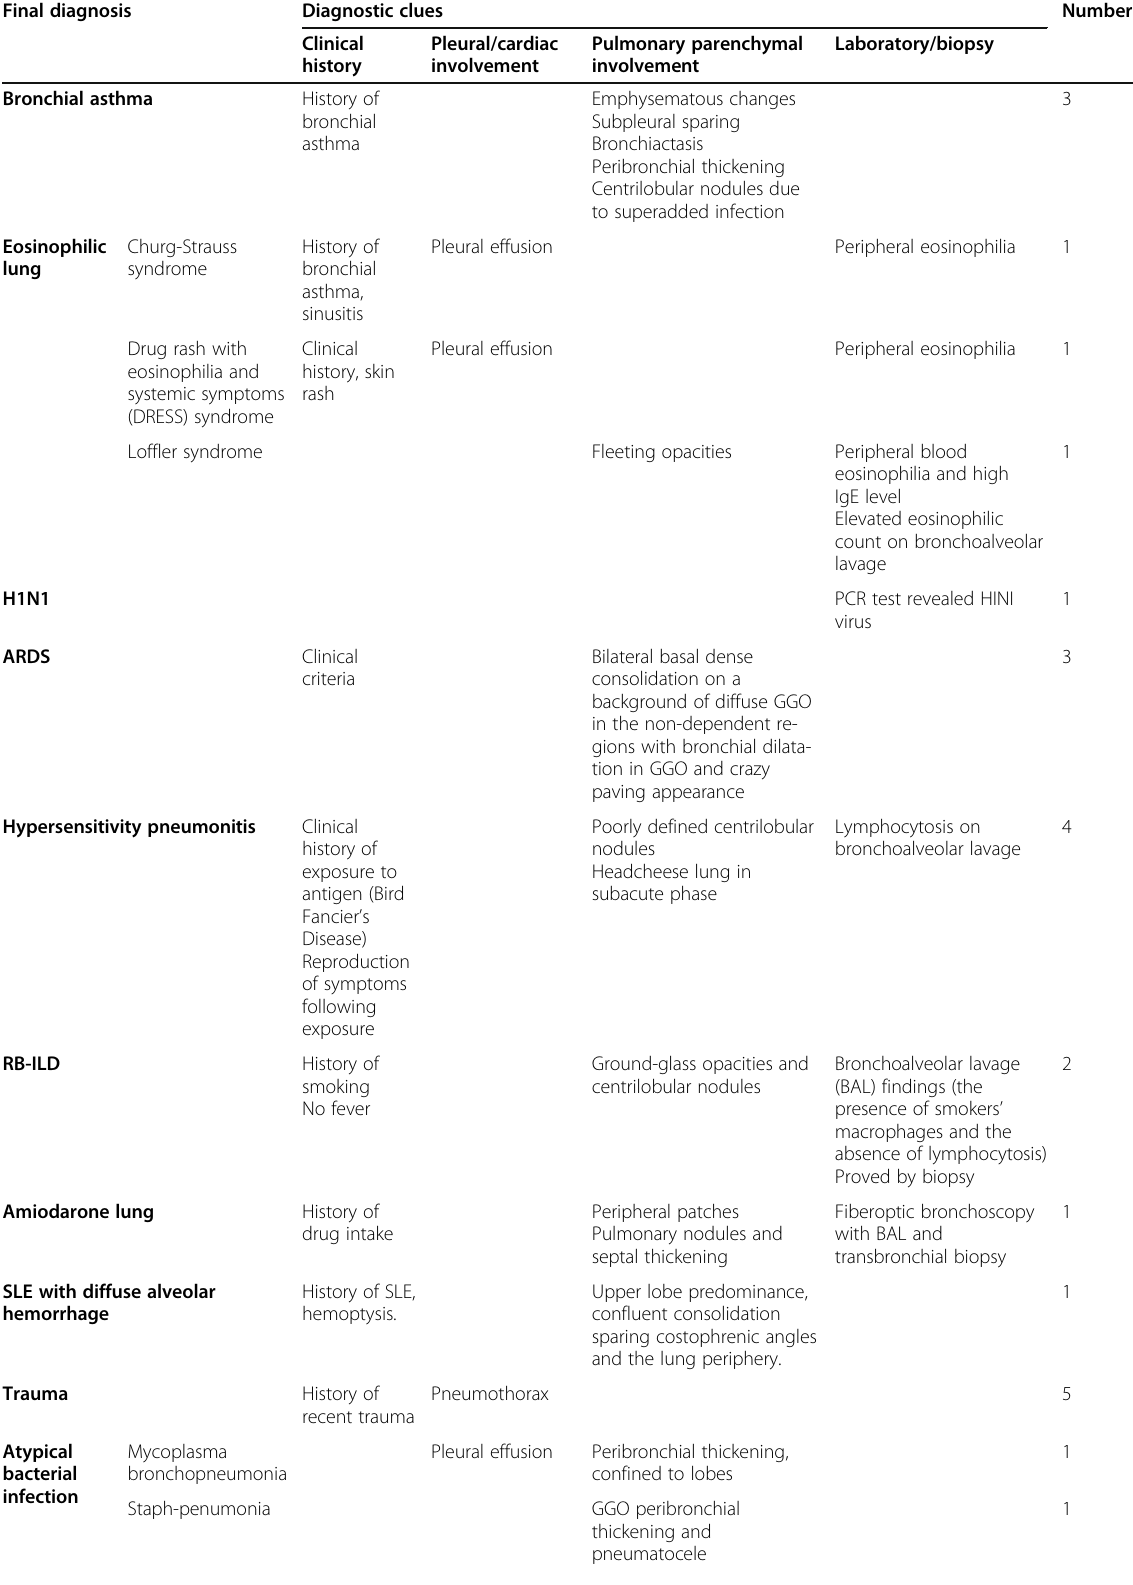
Table 5 Diagnostic clues for COVID-19